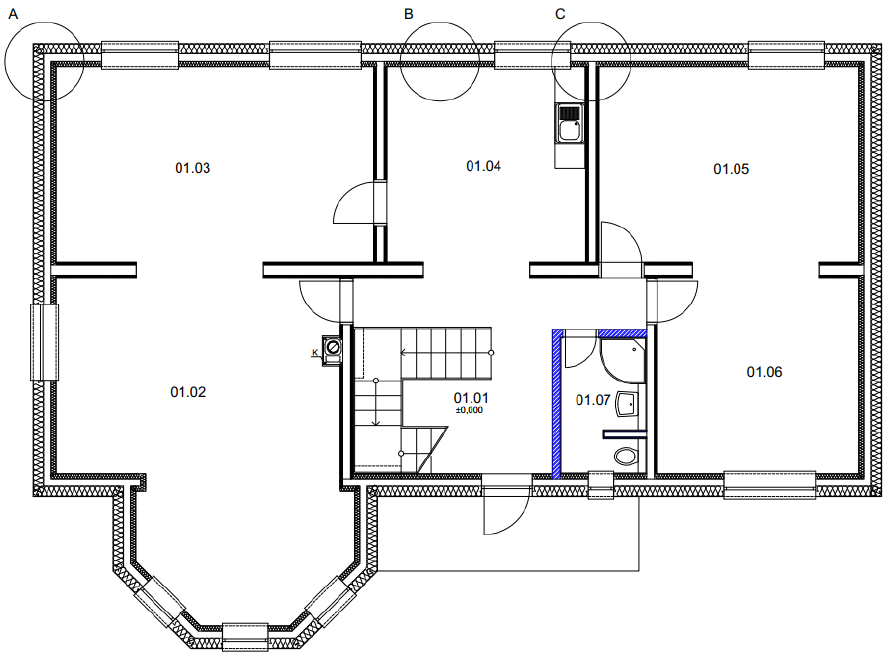
Figure 9. First floor plan showing the location of details A, B, and C; K — chimney for fireplace; the digit +0.000 indicates the ground floor elevation.